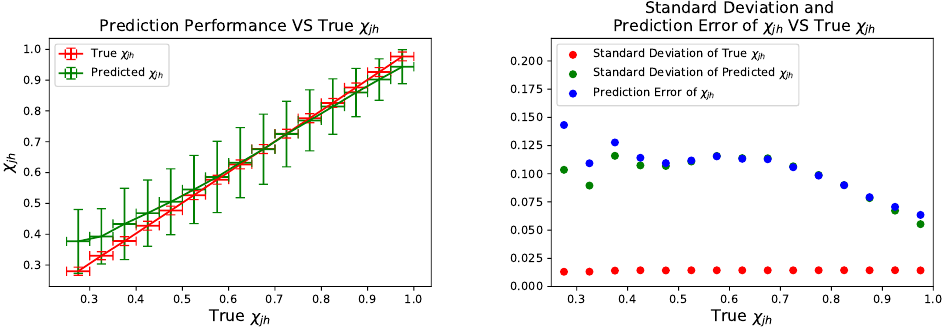
Figure 22 . Prediction Performance (left panel) and Standard Deviation, Prediction Error (right panel) VS χ jh